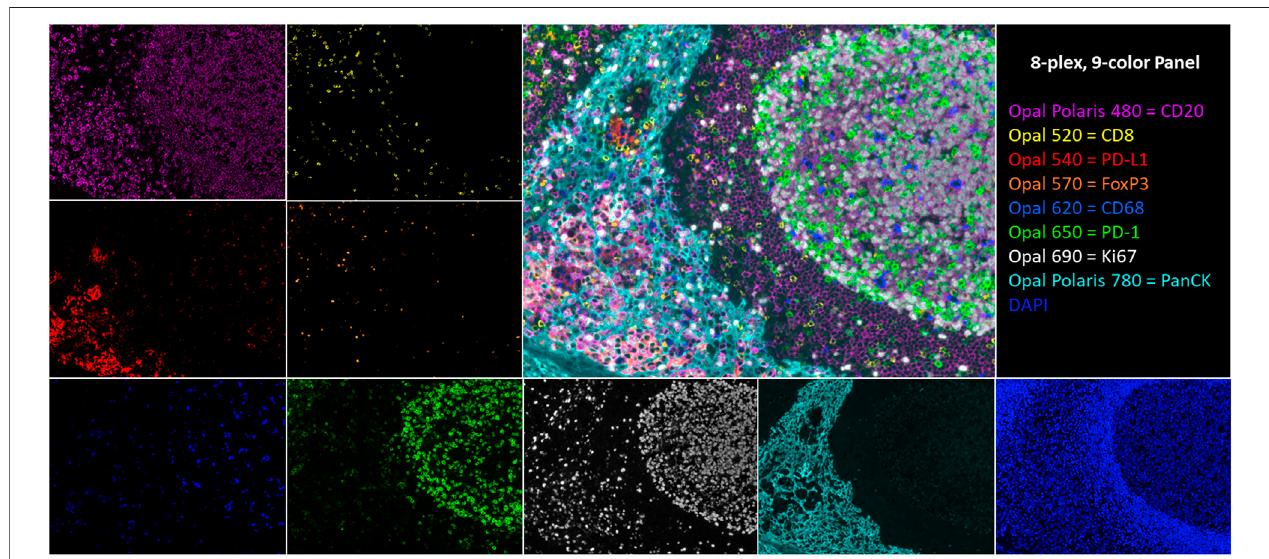
FIGURE1| An8-plex,9-color tonsilcompositeimagewithrespectivechannelmonopleximages:OpalPolaris480 (cid:1) CD20(purple),Opal520 (cid:1) CD8(yellow), Opal 540 (cid:1) PD-L1 (red), Opal 570 (cid:1) FoxP3 (orange), Opal 620 (cid:1) CD68 (blue), Opal 650 (cid:1) PD-1 (green), Opal 690 (cid:1) Ki67 (white), Opal Polaris 780 (cid:1) PanCK (teal), and DAPI